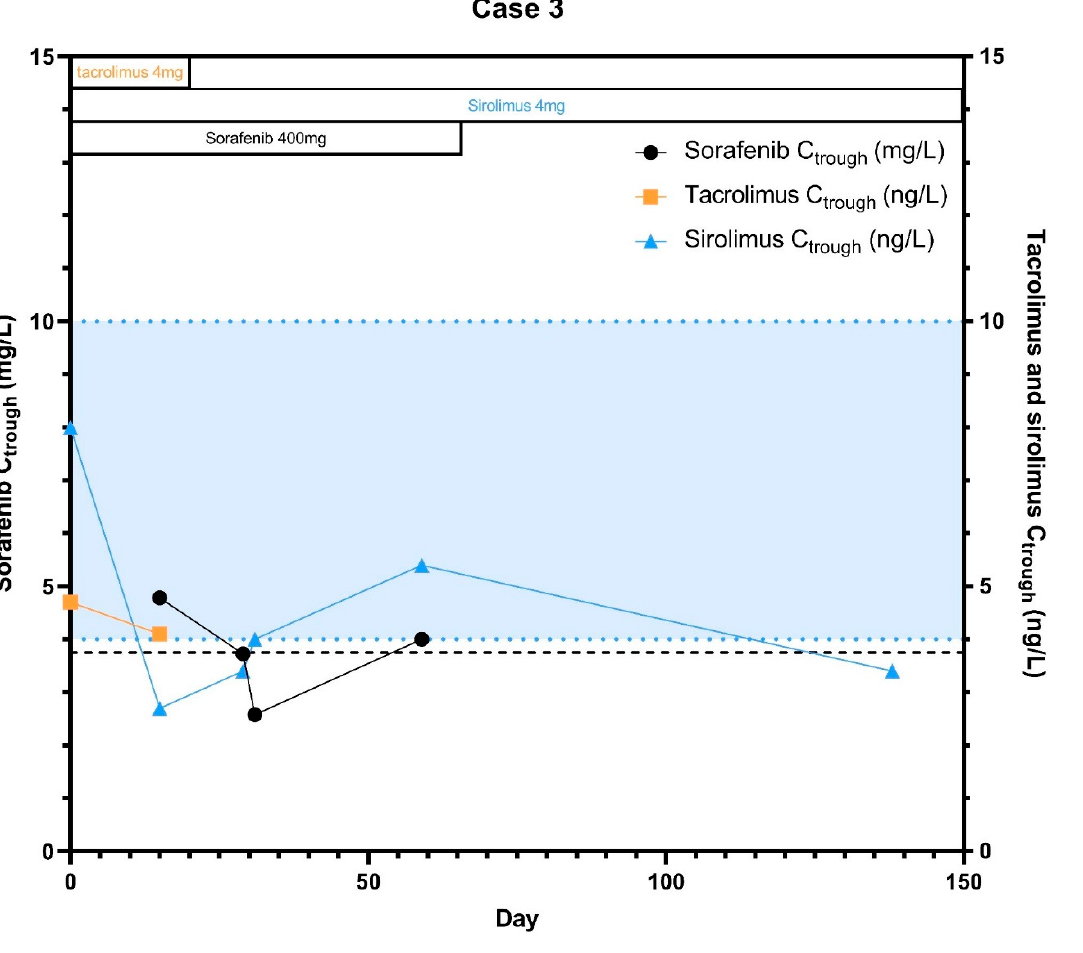
Figure 3. Sorafenib and tacrolimus C trough concentrations over time for Subject 3: The C trough levels are displayed over time after the start of sorafenib treatment. Furthermore the optimal C trough levels of both sorafenib and sirolimus are provided. Case 3 was initially treated with both sirolimus and tacrolimus but stopped tacrolimus short after start of sorafenib as was shown in this